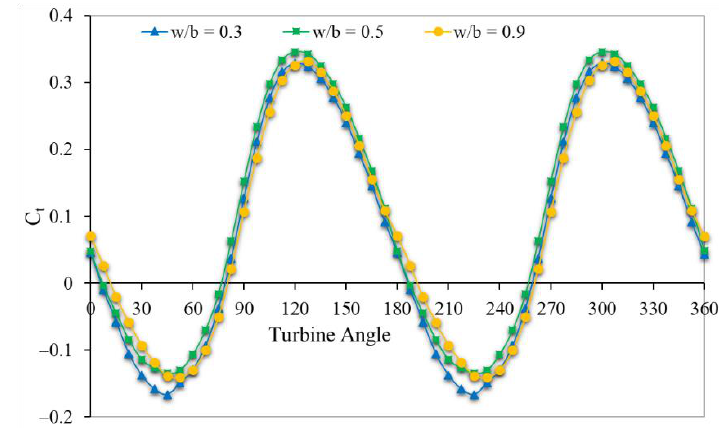
Figure 9. The effect of triangular plate end width.